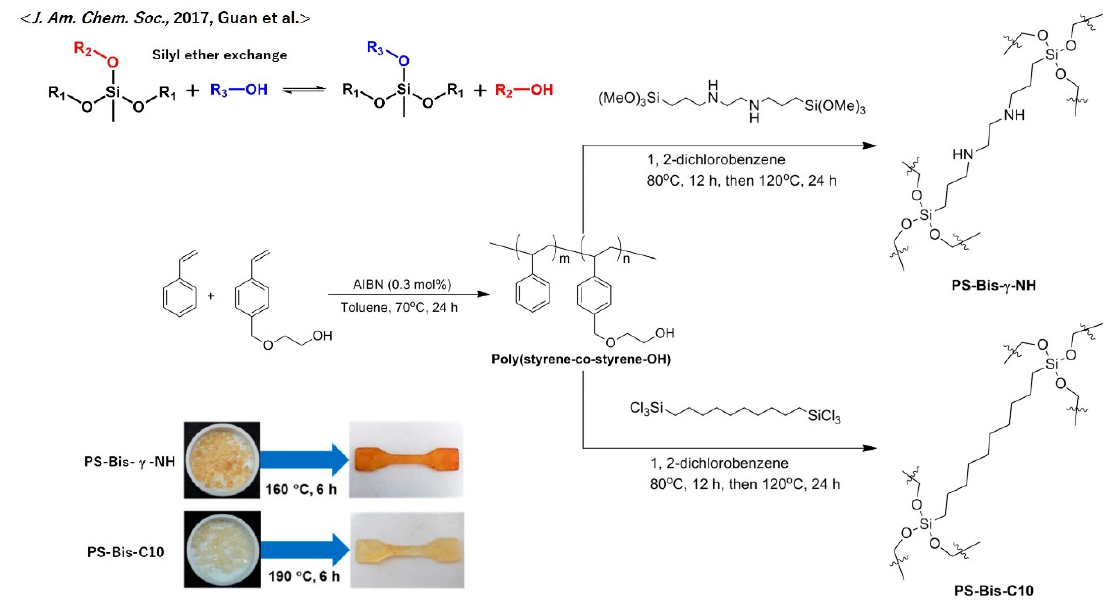
Figure 17. Molecular designs of vitrimer polystyrene according to ref. [70]. Please see the details of the cross-linking design in the text. Visual representations of the recyclability are also shown. Adapted with permission from ref. [70]. Copyright (2017) American Chemical Society.